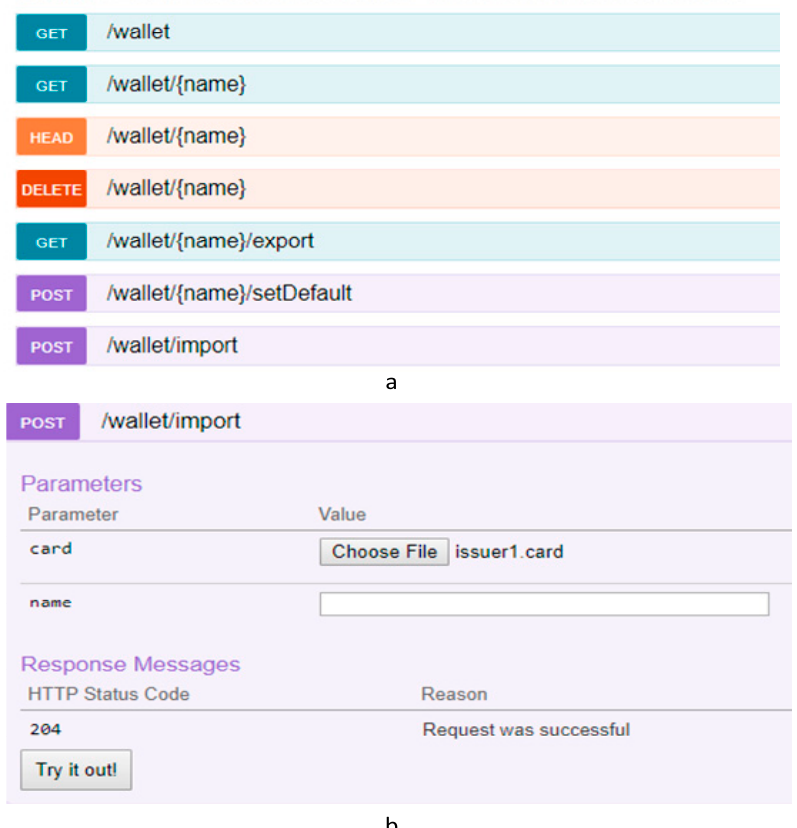
Figure 15. Composer REST Server explorer main interface.